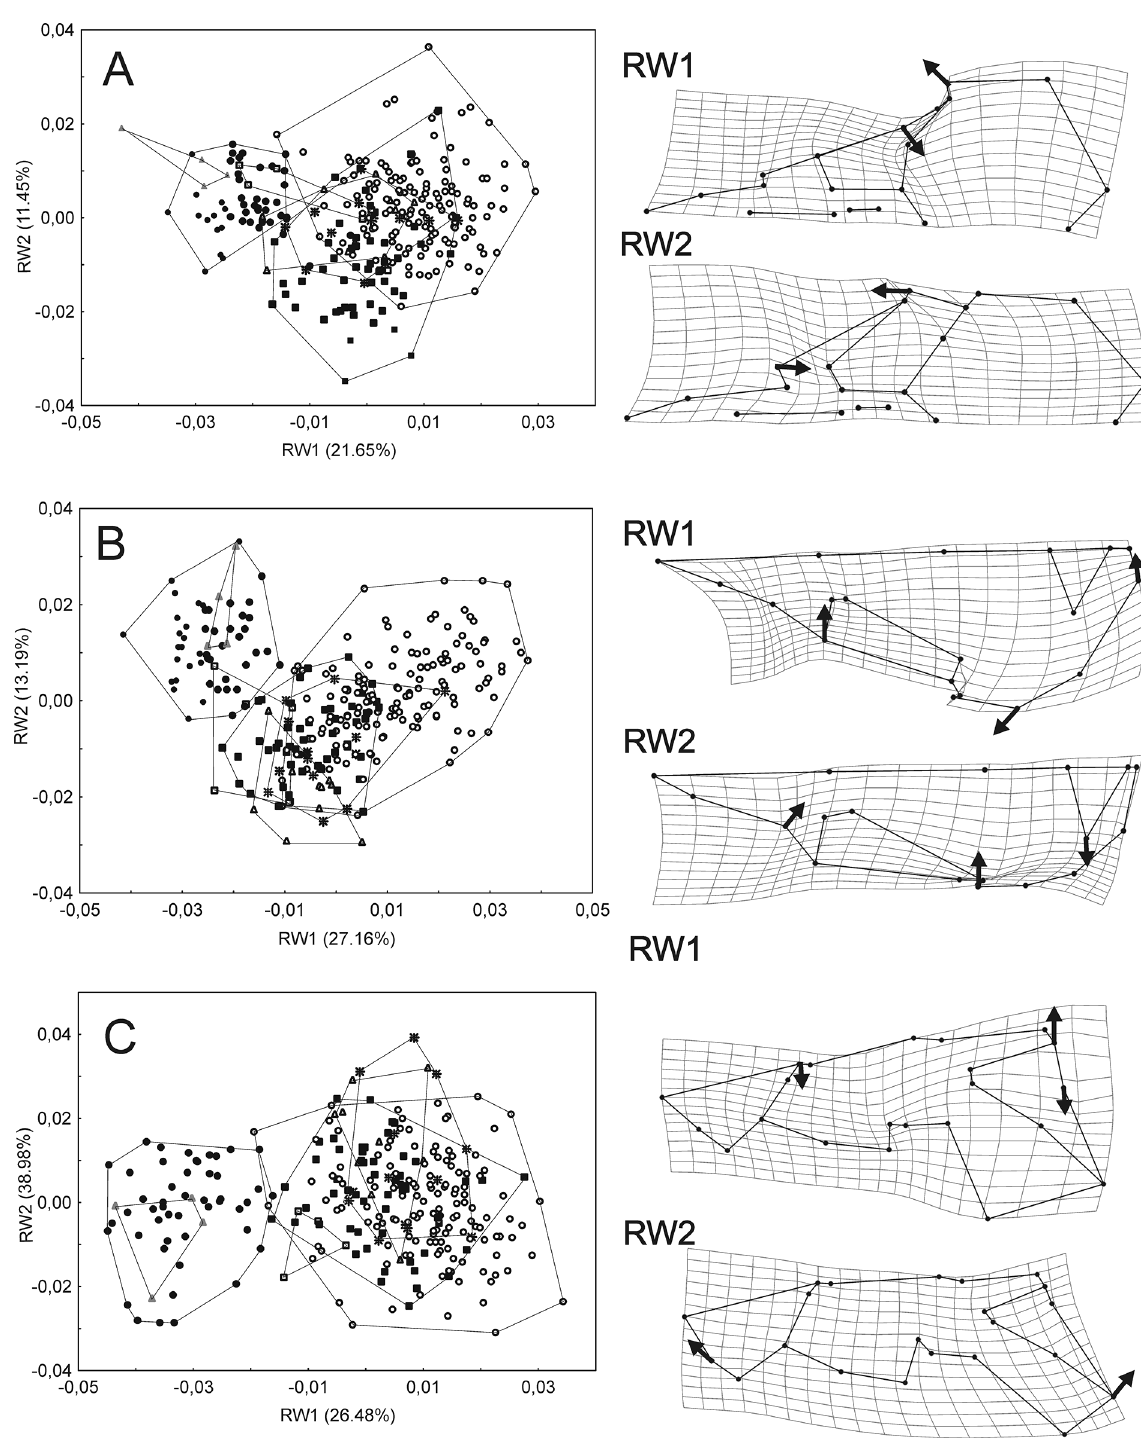
Fig. 6. Scatter plot of PCA results on shape variables of the (A) ventral, (B) dorsal and (C) lateral sides of Meriones crassus Sundevall, 1842 specimens. Legends: ○ = Iranian Plateau, ● = Western Zagros, * = Kuwait, Δ = Arabian, ▲ = Jeddah, □ = Jordan/NW Arabia, ■ = African. Deformation grids (two times magnified) along the first principal components, representing shape differences between configurations corresponding to minimal and maximal scores, are shown to the right of each plot. For the numbering of landmarks, see Fig.